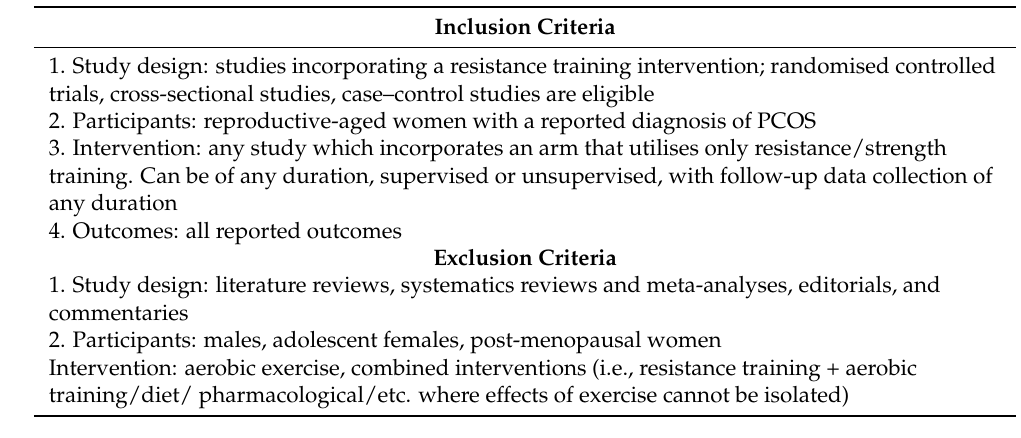
Table 1. Eligibility criteria for including studies in this scoping